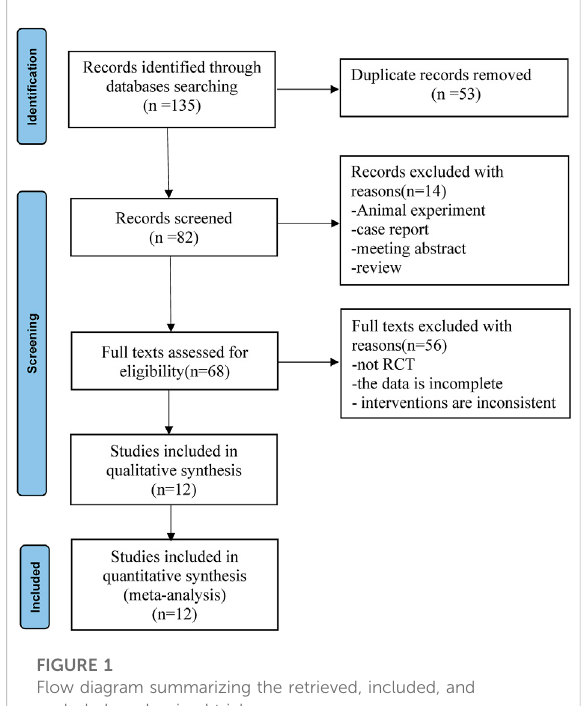
FIGURE 1 Flow diagram summarizing the retrieved, included, and excluded randomized